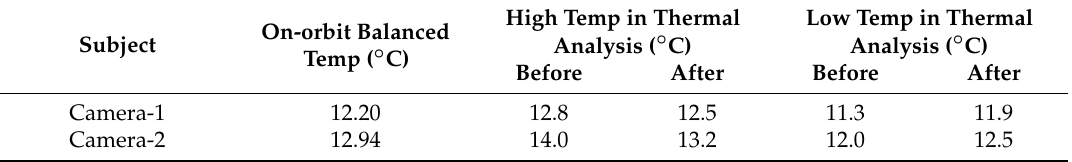
Table 17. Amendment comparison of temperature of instruments from in-orbit and thermal